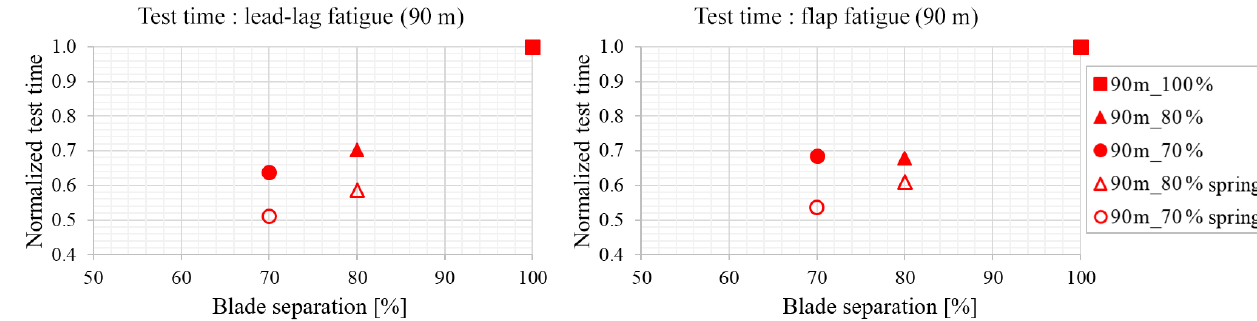
Figure 12. Effect of spring elements on fatigue test time of the 90m blade root segment.